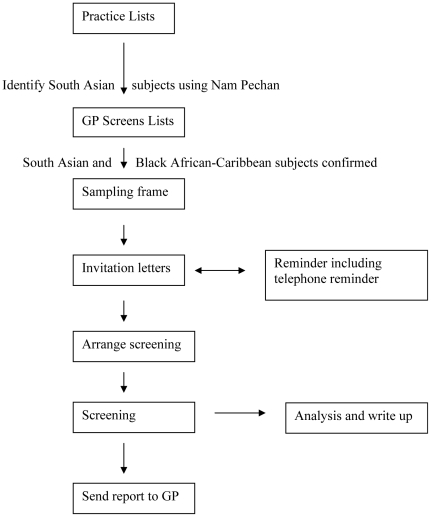
Flow of participants through study.